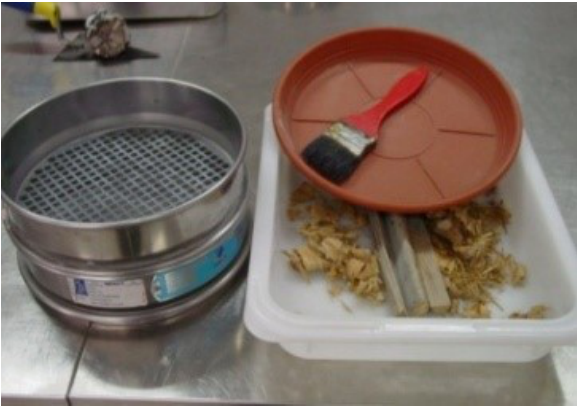
Figure 3: Equipment used in the grain size